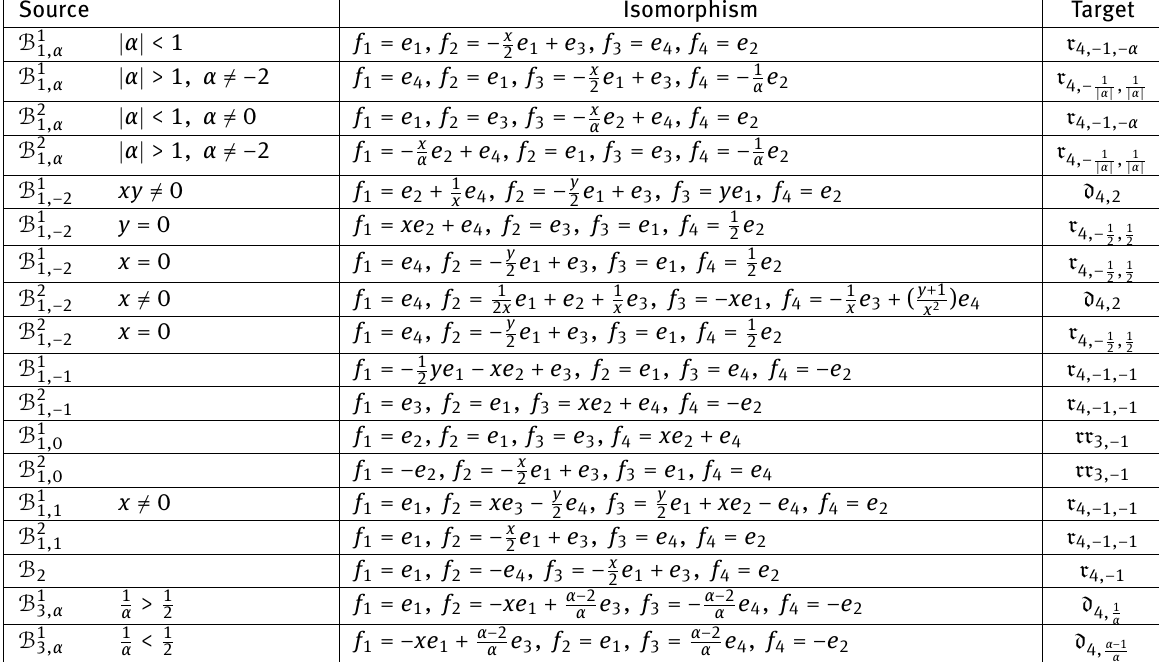
Table 6: Isomorphisms from the Lie algebras obtained in Table 4 onto the Lie algebras in Table